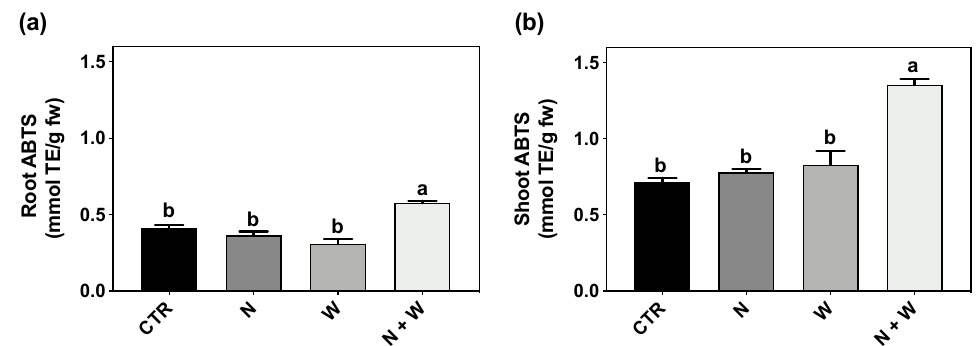
Figure 2. Total antioxidant capacity measured by ABTS in roots ( a ) and shoots ( b ) of tomato plants cv. Micro-Tom grown for 16 days under control (CTR; 10.5 mM N + 100% W), nitrogen deficit (N; 5.3 mM N + 100%W), water deficit (W; 10.5 mM N + 50% W) or combined nitrogen and water deficit (N + W; 5.3 mM N + 50% W). Data presented are mean ± SEM ( n = 3). Different letters above bars indicate significant differences according to Tukey’s HSD test ( p = 0.05).